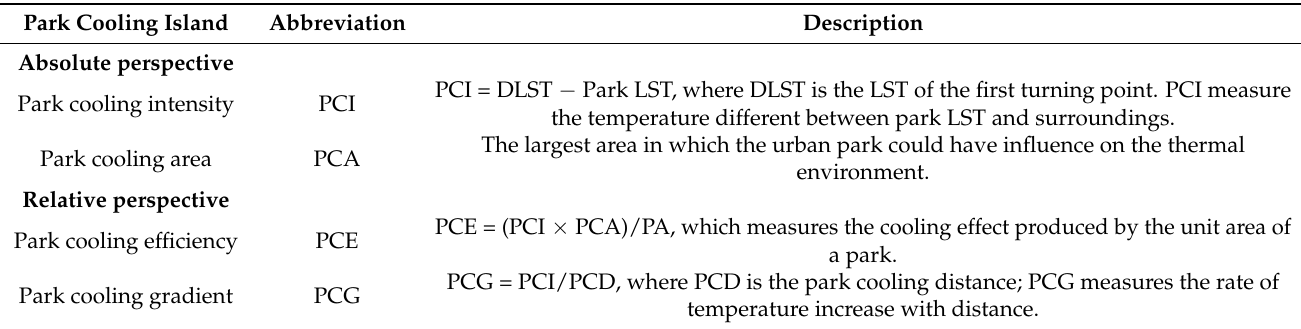
Table 2. Four aspects of the park cooling island in this